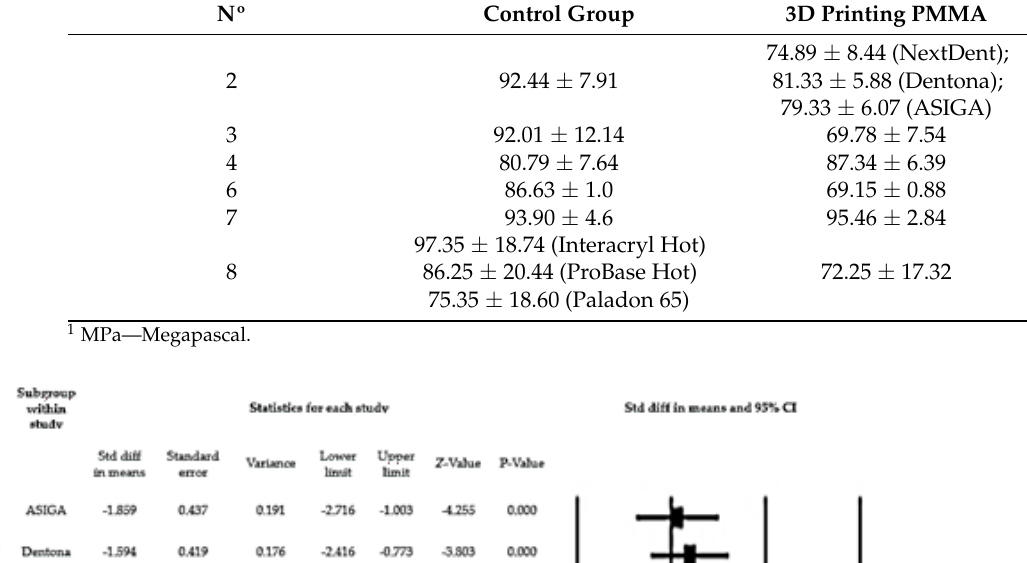
Table 4. Average values of flexural strength 1 .